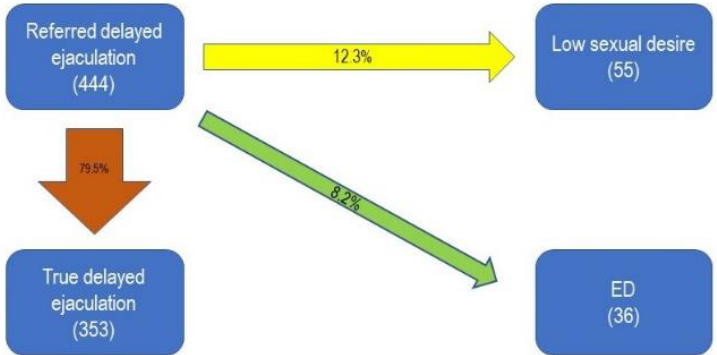
Figure 4. Prevalence of final diagnoses in patients who complained of delayed ejaculation at the first visit to the andrology clinic. ED: Erectile Dysfunction.